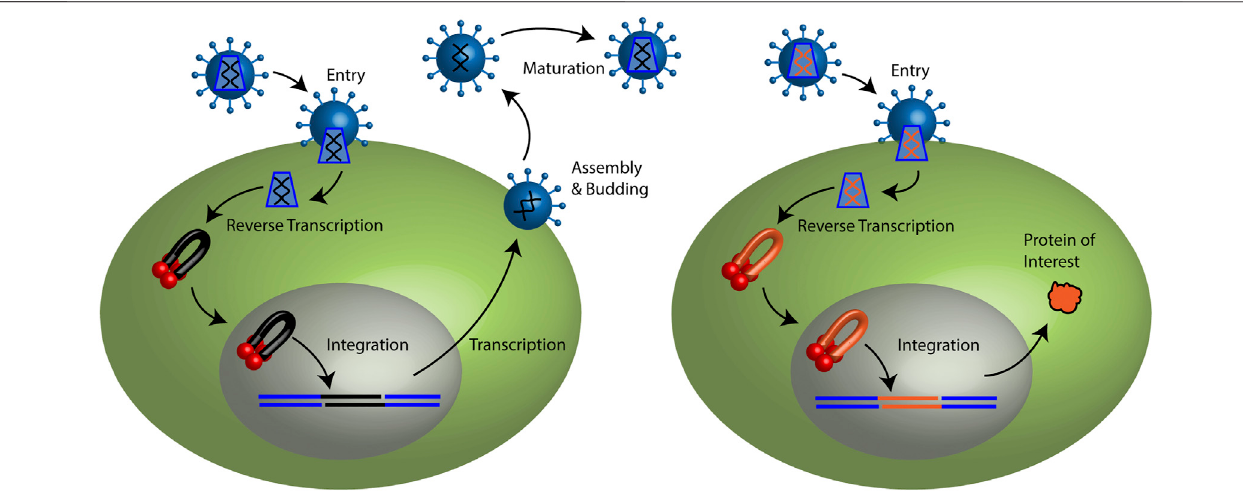
FIGURE 1 | Retroviral life cycle and retroviral vector particle transduction. (Left) Retroviruses may enter a target cell by membrane fusion. The capsid core is releasedtothe cytoplasm. Reverse transcriptioncopies the viralgenomicRNA(black lines)toalinear double strandedcDNA.Integrase bindsthe ends oftheviral cDNA formingapre-integrationcomplex(PIC).LentiviralPICsareabletocrossanintactnuclearmembranewhileallotherretrovirusesrequirecellulardivisiontoaccessthehost genome. Integrase mediates the stable integration of the vDNA (black) to the host genome (blue) generating the provirus. Host transcription machinery generates viral mRNAs and genomic RNA. Progeny viral particles assemble and are released from the plasma membrane. Following budding from the cell, viral enzyme protease cleaves the polyproteins to generate a mature infectious virus particle. (Right) Retroviral vector particles recapitulate the early steps of the retroviral life cycle. Viral RNA and cDNA depicted in red. However, they do not encode viral proteins. Only the protein of interest is expressed.